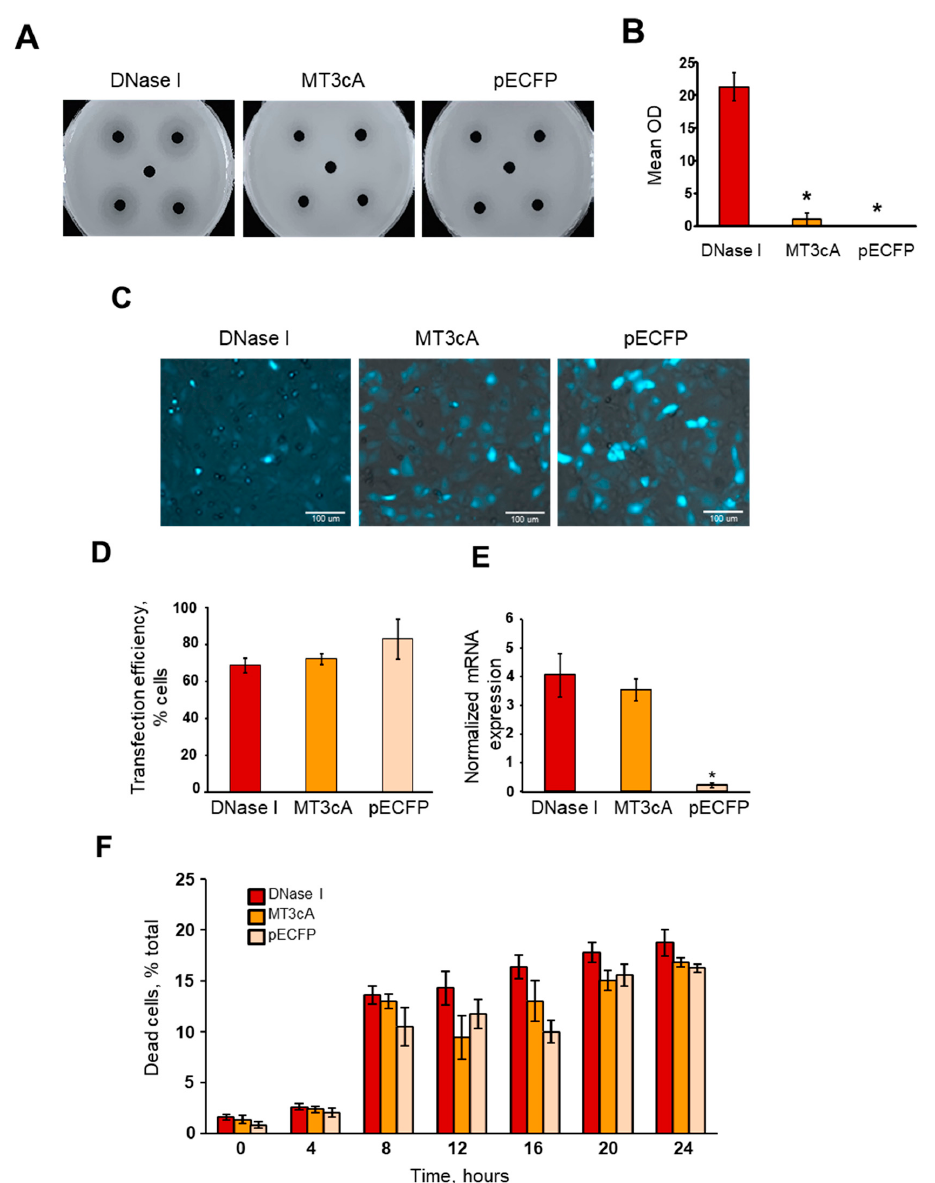
Figure 1. Overexpression of native DNase I or inactive DNase I mutant MT3cA in kidney tubular epithelial cells. ( A ) The DNase activity in the total protein extract of NRK-52E cells 24 h post transfection was measured using an SRED assay. Representative images showing DNA degradation circles in agar gel caused by pECFP-DNase I, pECFP-MT3cA or control pECFP transfection. ( B ) Quantification of the SRED assay data ( n = 4, * p < 0.01 compared to DNase I). ( C ) Representative fluorescent/phase contrast (CFP + PhC) images showing NRK-52E cells transfected with pECFP-DNase I, pECFP-MT3cA, or pECFP 8 h after transfection. ( D ) Total fluorescence of the transfected cells 8 h after transfection. ( E ) DNase I expression in NRK52E cells transfected with pECFP-DNase I, pECFP-MT3cA (its inactive mutant) or pECFP measured by real-time RT-PCR 8 h after transfection. mRNA expression levels were normalized by 18 s housekeeping gene ( n = 4). ( F ) PI cell death assay showing the mean percentage of dead NRK-52E cells transfected with pECFP-DNase I, pECFP-MT3cA, or pECFP 0-24 h after transfection ( n = 4, * p < 0.01 compared to DNase I). In panel ( F ), the difference in cell death was not statistically significant between the constructs.